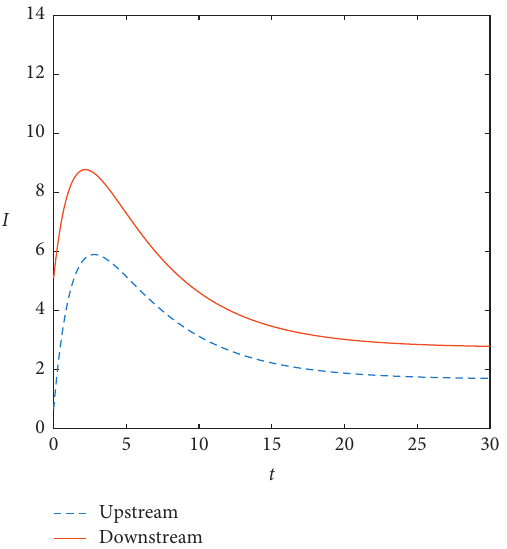
Figure 10: Optimal trajectory of pollution abatement investment under non-cooperation when the planning period T ⟶ ∞ .